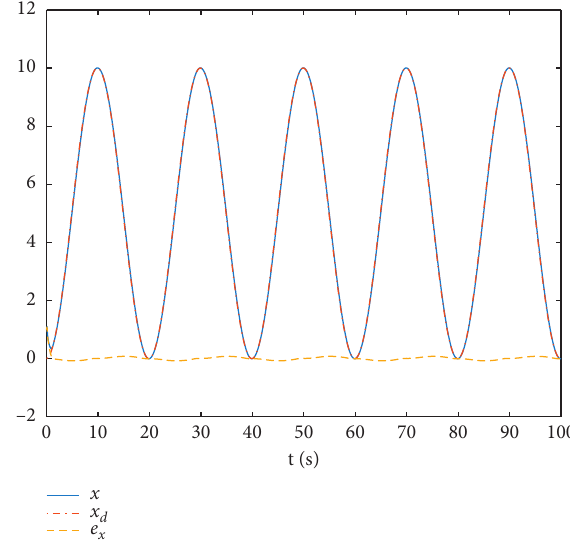
Figure 2: Trajectories of position x , ideal position x